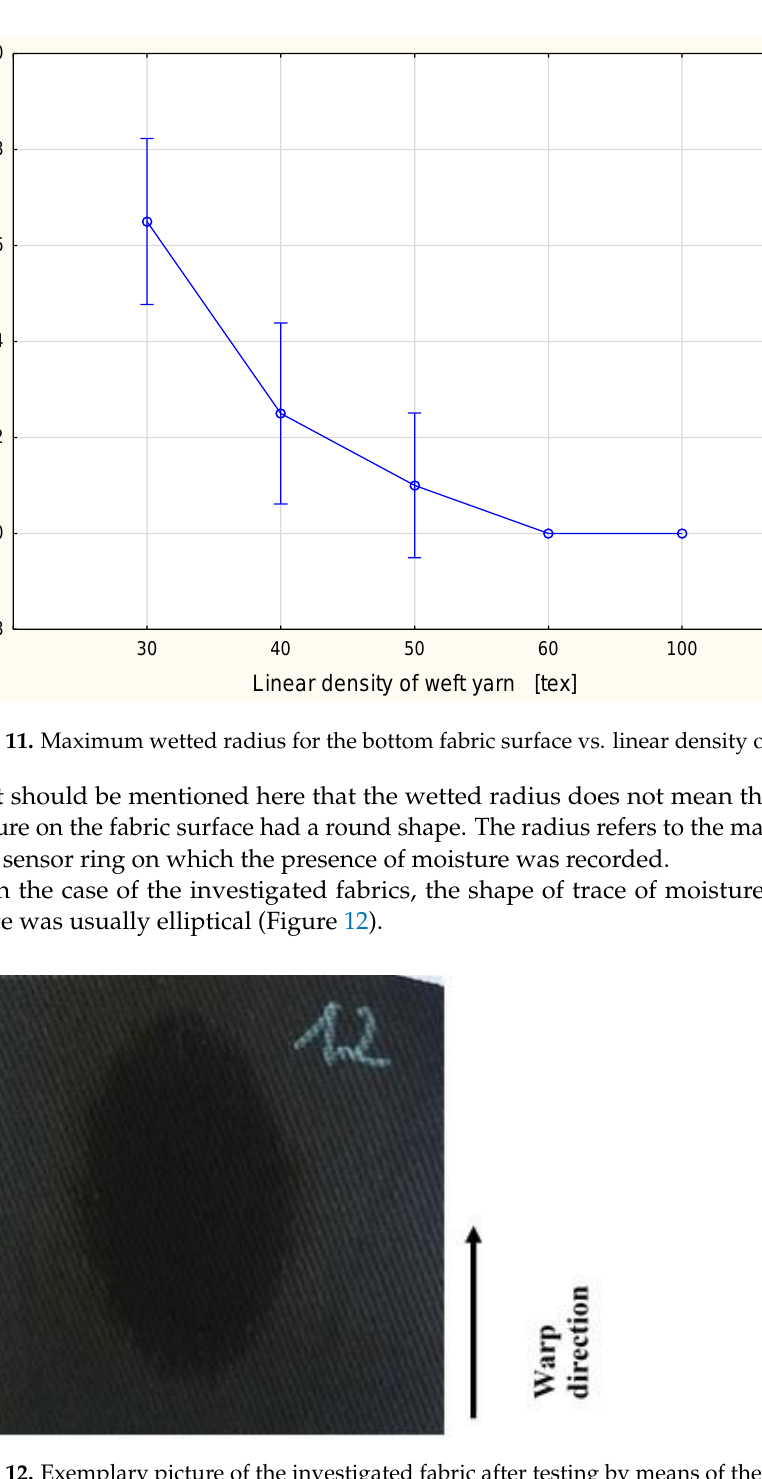
Figure 10. Maximum wetted radius for the top fabric surface vs. linear density of the weft yarn.